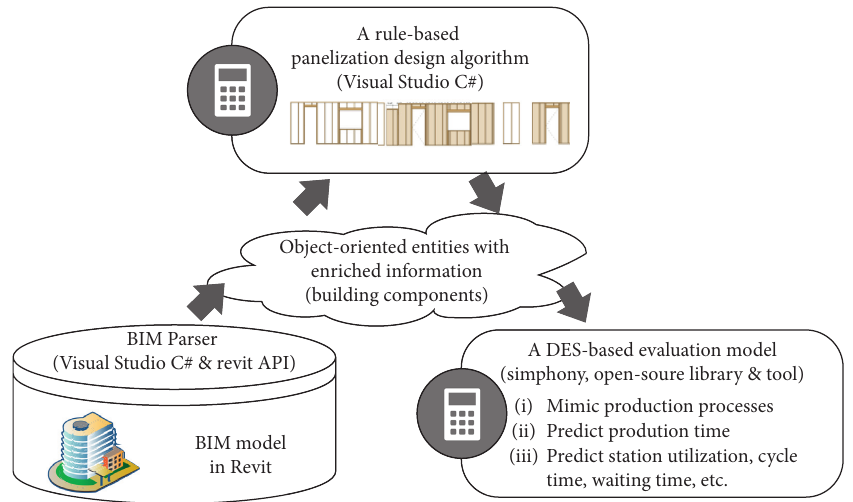
Figure 6: System